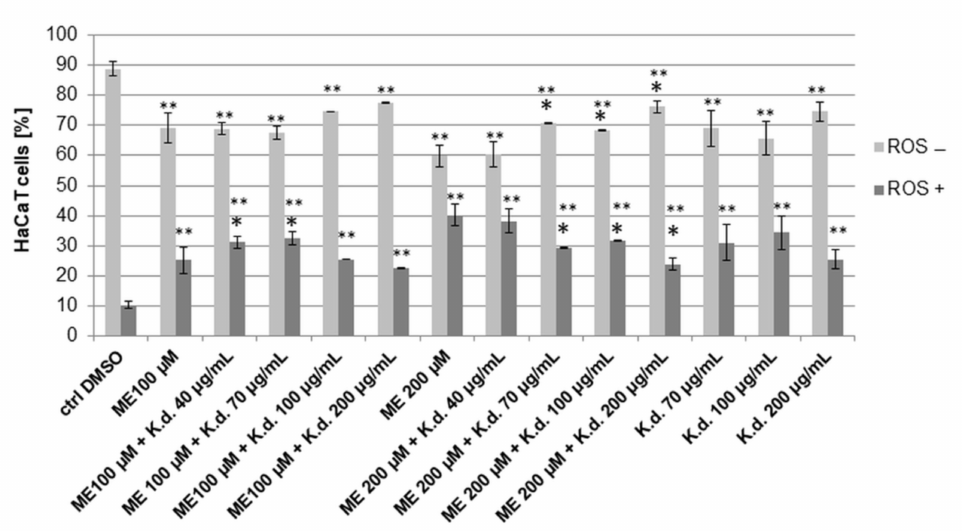
Figure 8. The effects of K. daigremontiana water extract on menadione-induced oxidative stress in HaCaT cells. The cells were treated with menadione (ME) and the extract (K.d.) for 24 h and analyzed by flow cytometry. The concentration of DMSO (control sample) was 0.2 % ( v / v ). The values represent the means ± SD of three independent experiments. Error bars indicate standard deviations. Significant differences relative to menadione (ME 100 µ M or ME 200 µ M) or the control are marked with “*” and “**”, respectively (Student’s t -test, p <